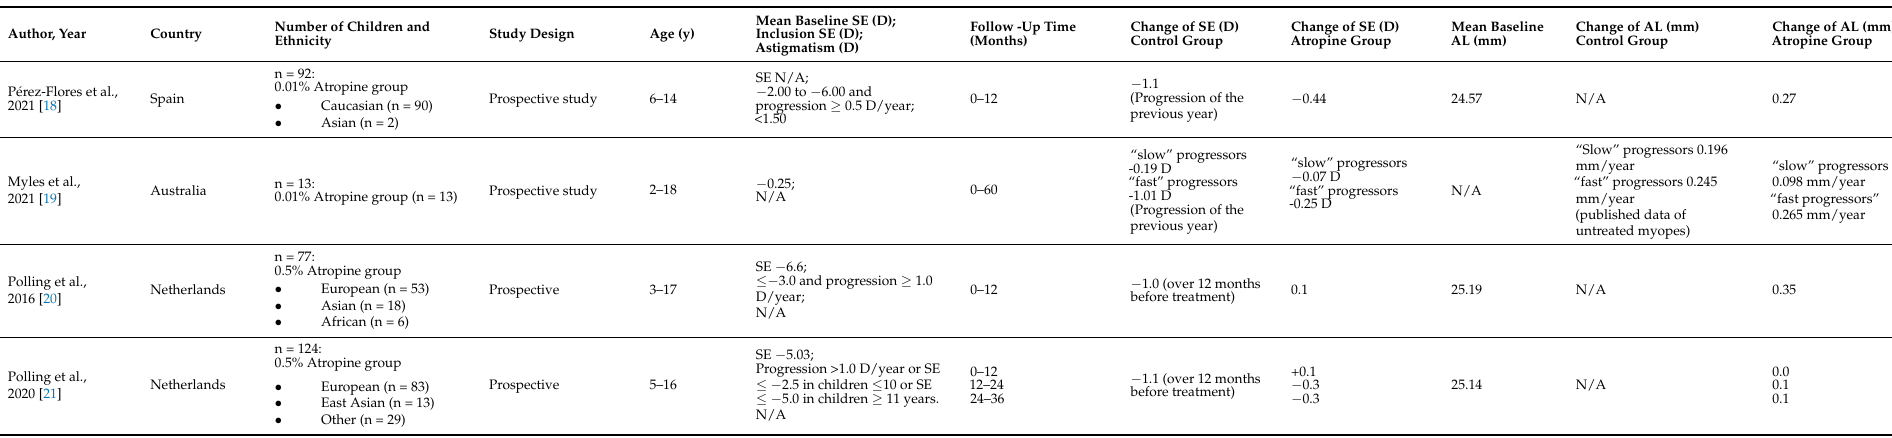
Table 1. Characteristics of prospective studies included in the analysis.